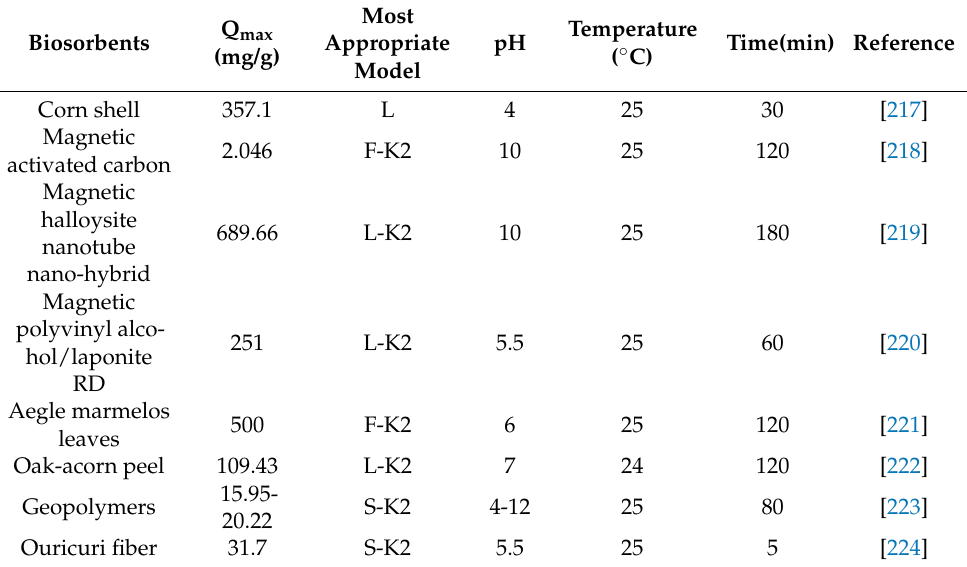
Table 9. Summary of bio-waste-derived adsorbent studies in 2017.